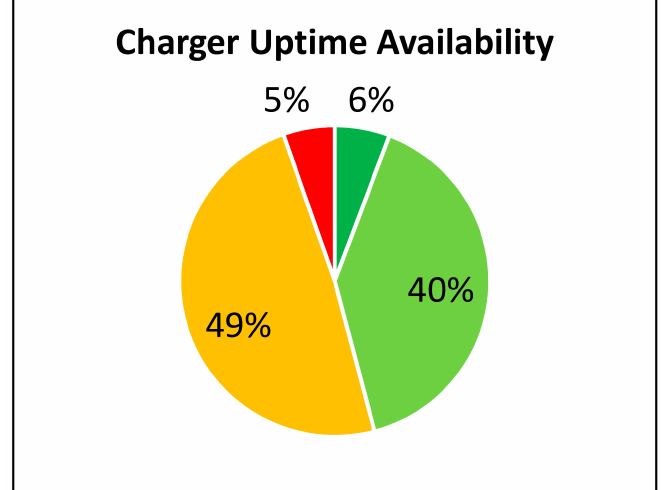
Figure 21. Rapid charge point uptime availability satisfaction.